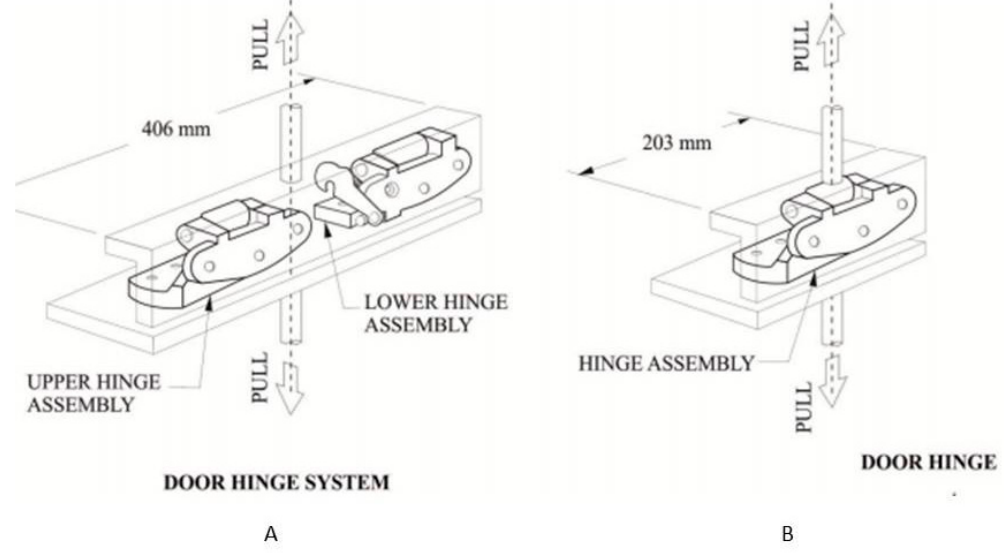
Figure 3. The dimensions of the experimental test apparatus (( A ) test apparatus for hinge system evaluation, ( B ) test apparatus for single hinge evaluation).